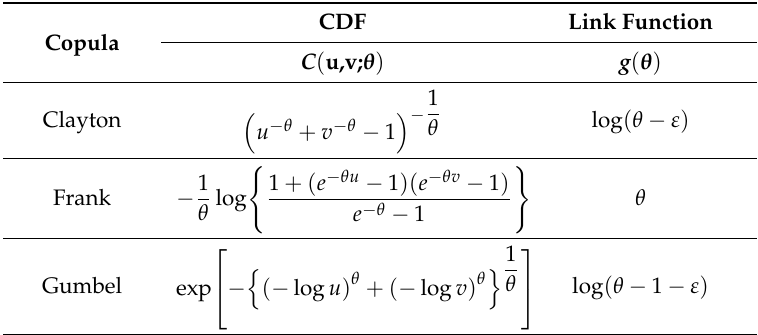
Table 3. Definition and properties of the Archimedean copula used in the study ( ε = 10 − 7 ).